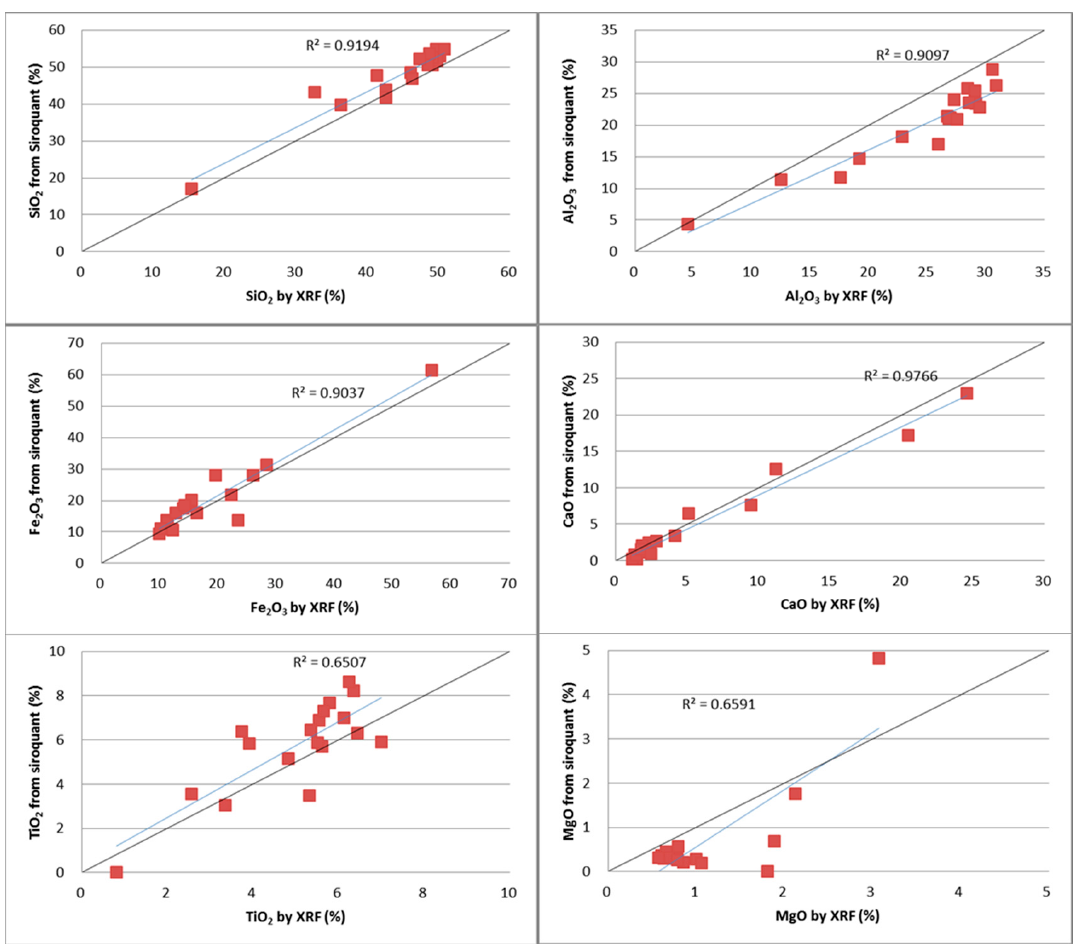
Figure 6. Comparison of observed normalized oxide percentages from chemical analysis ( x -axis) to oxide percentages for sample ash inferred from XRD analysis data ( y -axis). The diagonal line represents equality in each plot.